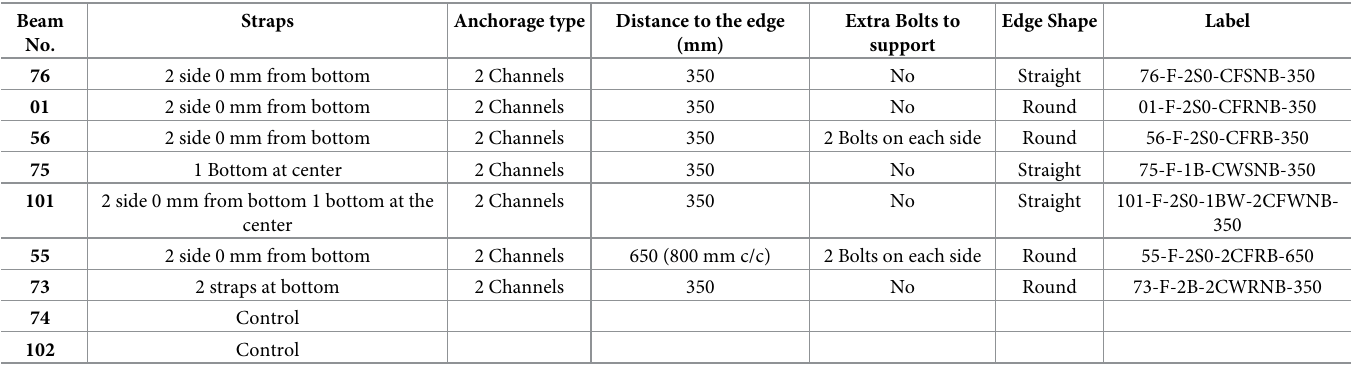
Table 6. Specimen labels in this paper. Beam No.